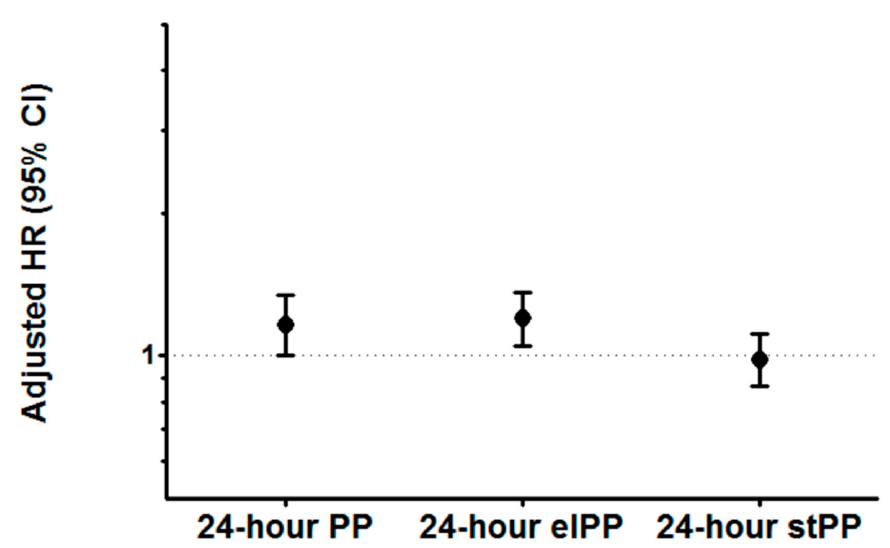
Figure 3. Adjusted hazard ratio (HR) and 95% confidence interval (CI) for cardiovascular events of 24 ‐ hour pulse pressure (PP), elastic PP (elPP) and stiffening PP (stPP), expressed per one standard deviation increment of each PP component. Adjustment included age, sex, diabetes, previous events, estimated glomerular filtration rate, left ventricular (LV) hypertrophy, left atrial enlargement, asymptomatic LV systolic dysfunction, 24 ‐ hour heart rate, 24 ‐ hour mean arterial pressure and the use of a diuretic, beta blocker, calcium channel blocker, angiotensin ‐ converting enzyme inhibitor, angiotensin receptor blocker and alpha blocker. Adjusted HR (95% CI) is 1.16 (1.00–1.34), 1.20 (1.05–1.36) and 0.98 (0.86–1.11) for 24 ‐ hour PP, 24 ‐ hour elPP and 24 ‐ hour stPP, respectively.